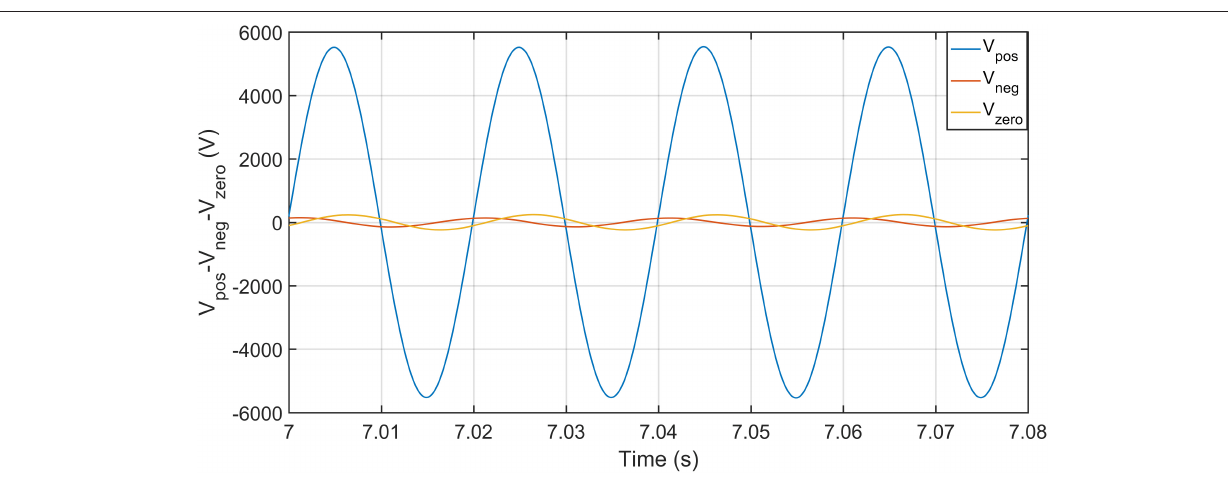
FIGURE 5 | Performance of 2nd stage SVSF for voltage unbalance components at